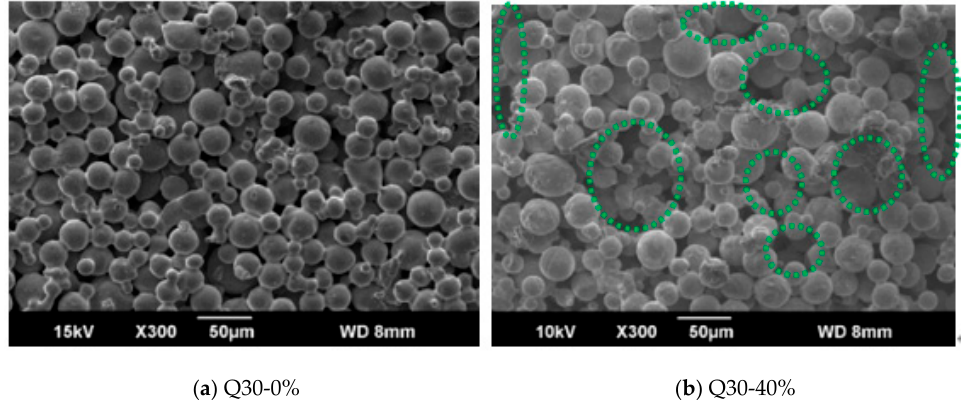
Figure 6. Electron micrographs of porous microchannels with pore-forming agent. Green dotted circle represent large void created by PFA.